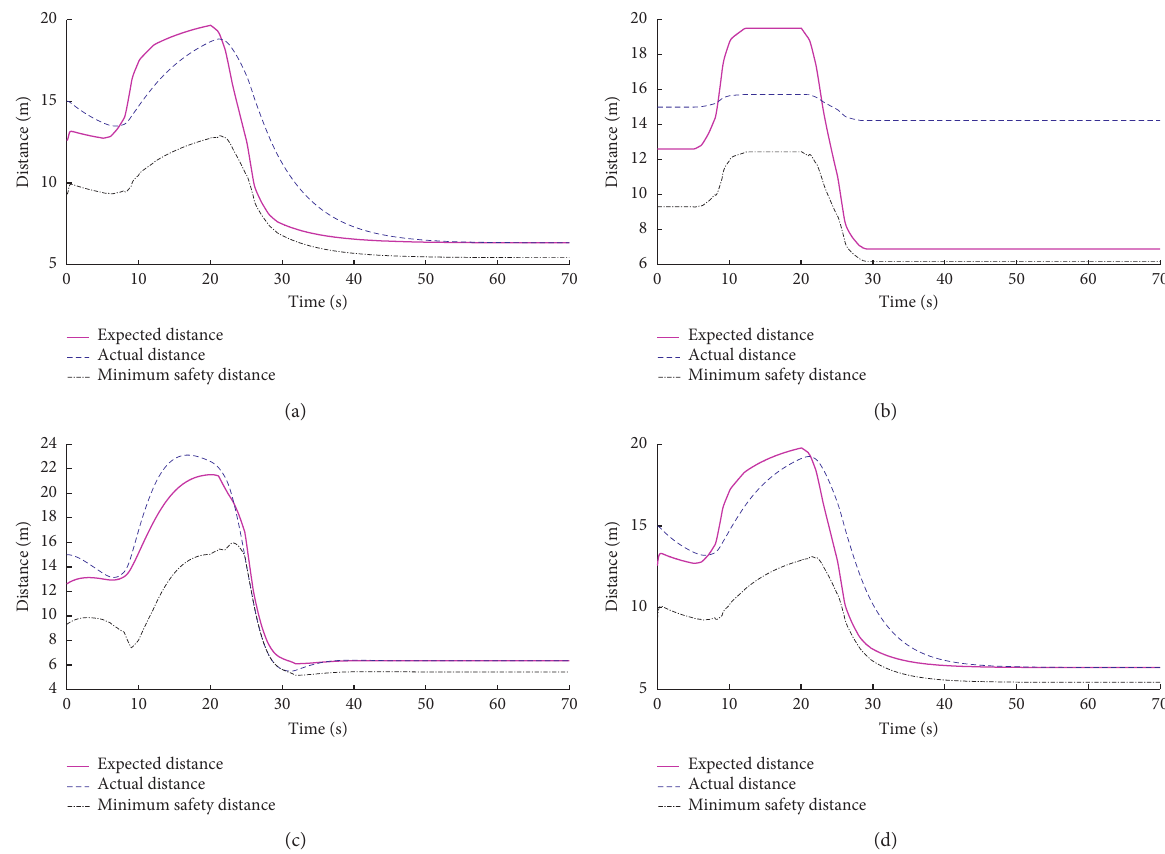
Figure 11: Distances of the LV and the FV of four controllers. (a) The MPC controller based on Quadprog. (b) The Incremental PID controller. (c) The Switch controller. (d) The MPC controller based on